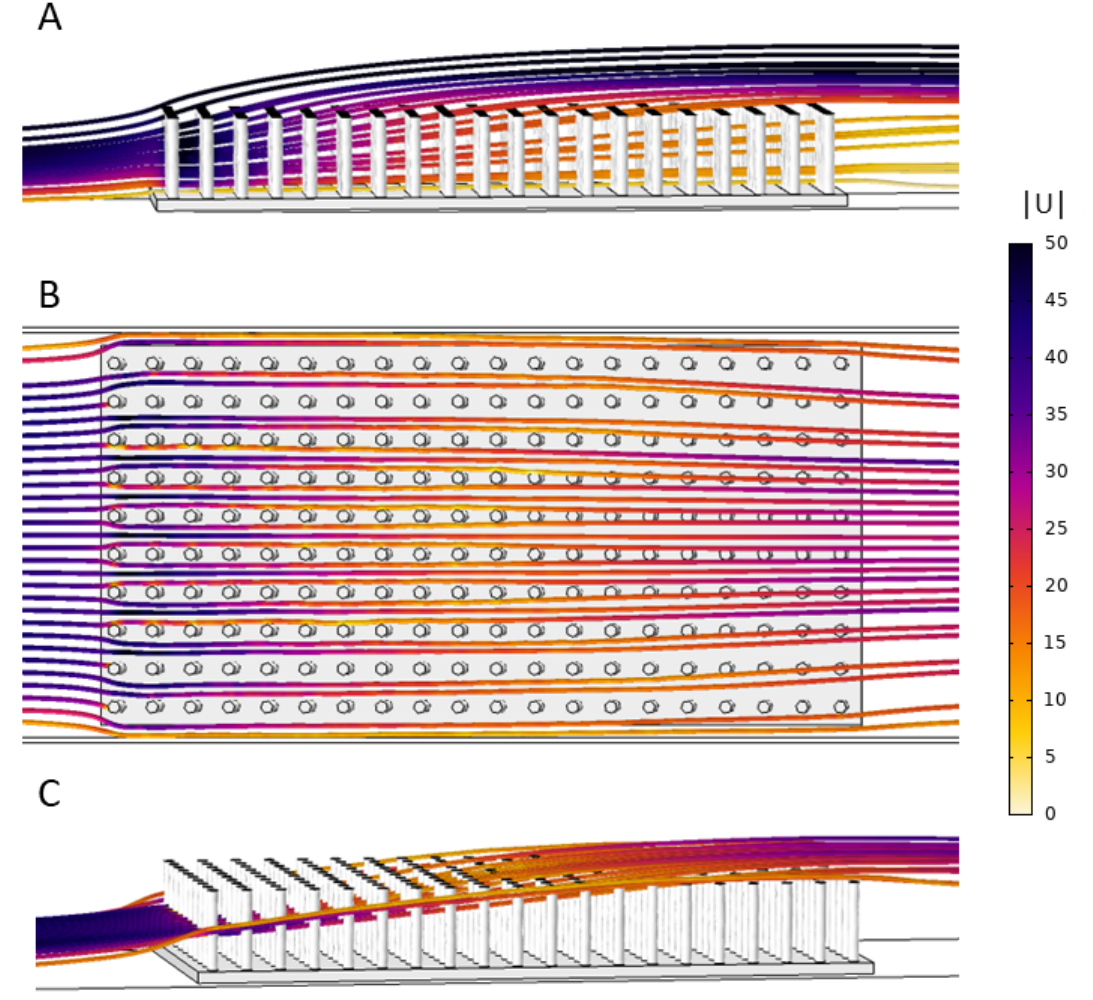
Figure 8. Streamlines showing the flow trajectories through the 10 × 20 model that is 2 cm in height. The color of the streamline corresponds to the velocity magnitude: ( A ) side view showing the magnitude and direction of flow through the cylinders using streamlines seeded in the vertical plane parallel to flow; ( B ) top view of streamlines that start at the midpoint of the cylinders in the z -direction along a horizontal line; and ( C ) the same streamlines as ( B ) in side